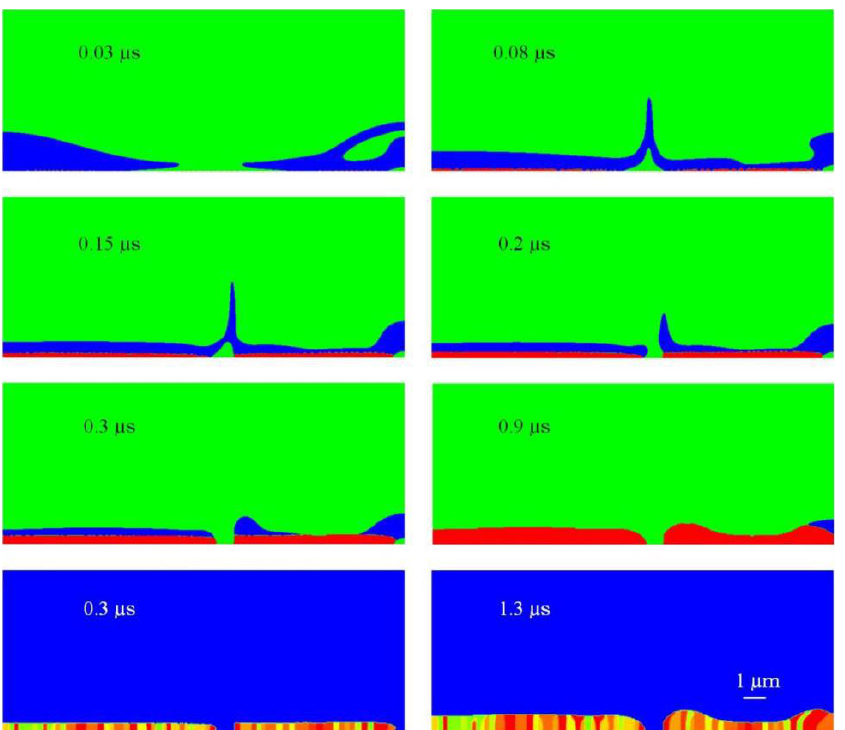
Figure 12. Air entrapment suppression in binary droplet impact with one being hollow. At 0.03 µ s, when the spreading process just begins, the counter flow in the hollow drop has emerged due to the smaller dynamic pressure within the void. The uprising